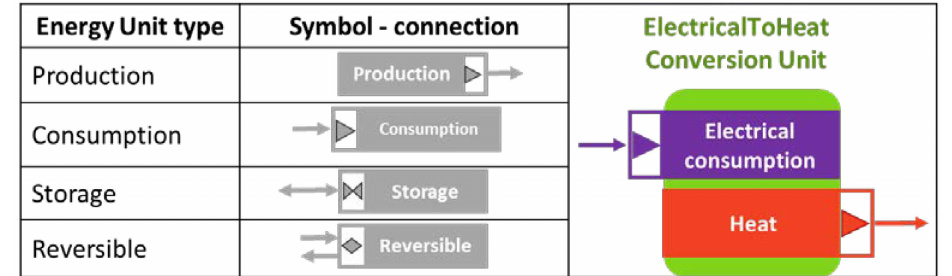
Figure 5. Sample of OMEGAlpes graphical representation.